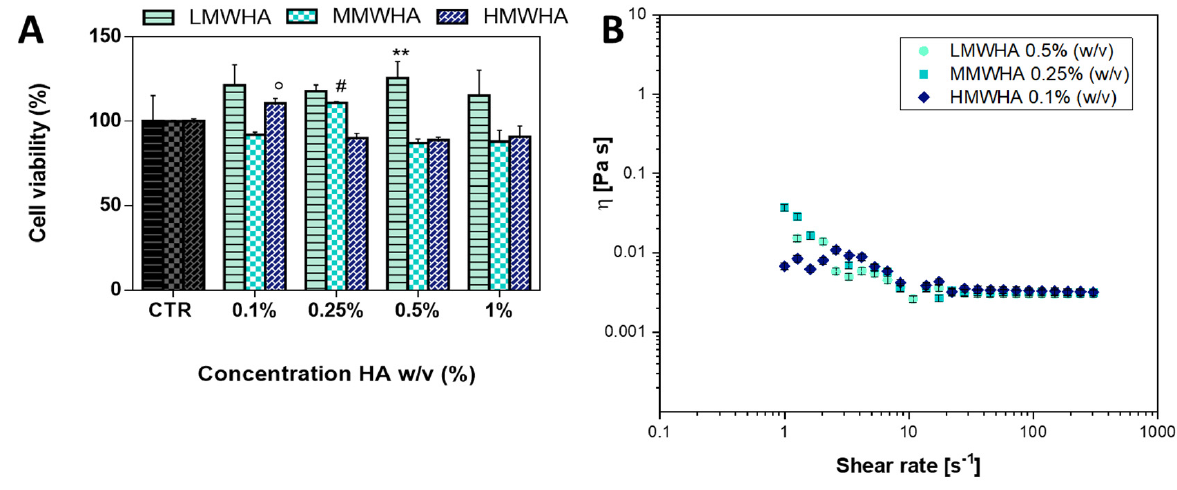
Figure 1. ( A ) Cell viability test after 24 h for hUCMSCs exposed to LMWHA, MMWHA, and HMWHA at concentration of 0.1, 0. 25, 0.5, and 1% ( w / v ). All results were presented as mean ± standard deviation. Each error bar represents 1 standard deviation and serves as the estimate of standard uncertainty. The data are representative of 3 repeated experiments in triplicate. ** p < 0.01, # p < 0.01, ° p < 0.01. ( B ) Steady shear tests. Viscosity as a function of shear rate for LMWHA, MMWHA, and HMWHA in PBS solution. The viscosity decreases by increasing the shear rate (shear thinning behaviour).